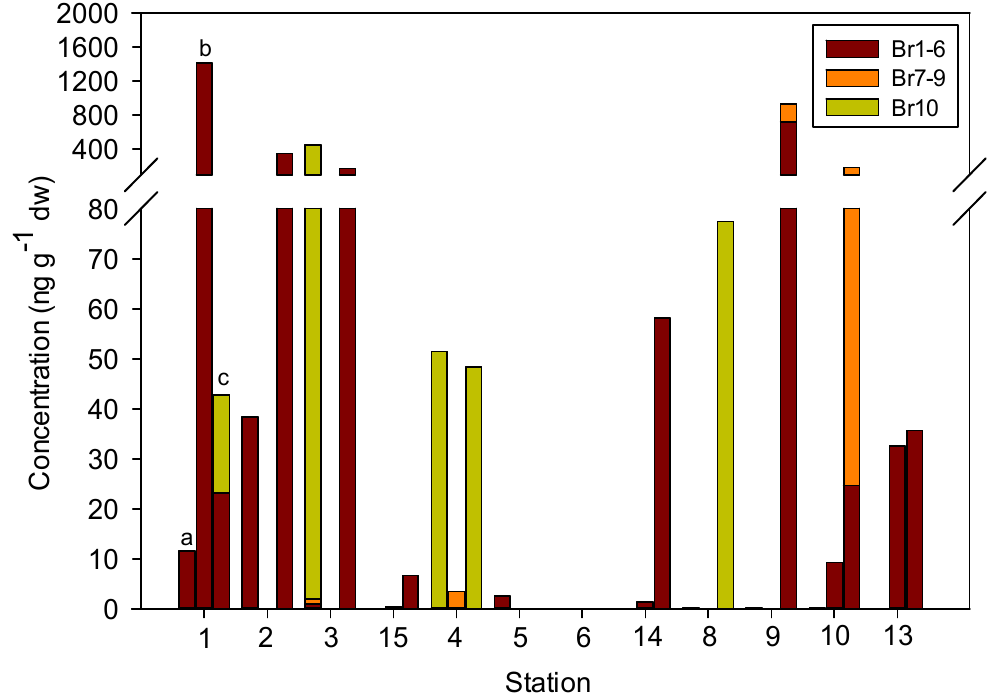
Figure 3. PBDE concentrations in zooplankton samples at each sampling station. Note: a: August